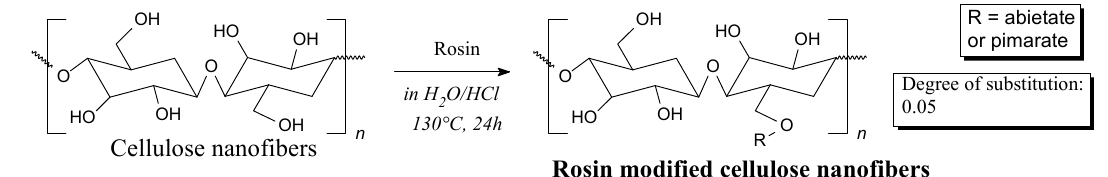
Scheme 76. Preparation of rosin-modified cellulose nanofibers.